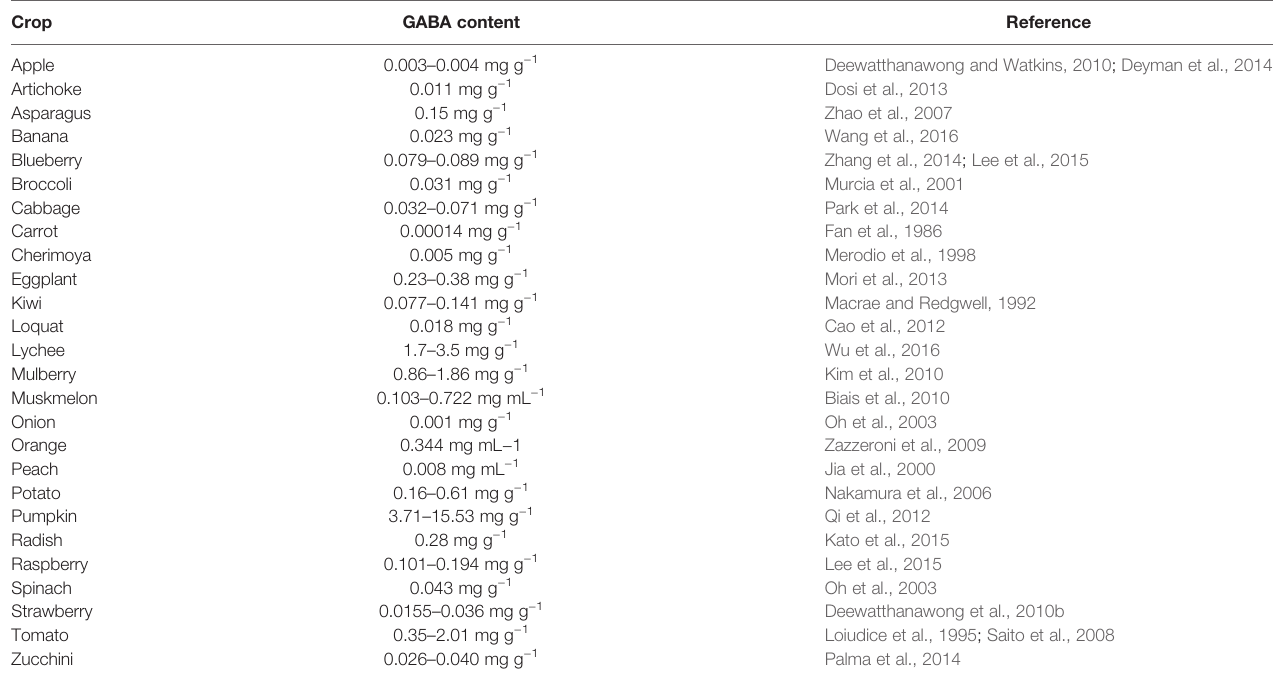
TABLE 1 | GABA content in crops. Crop